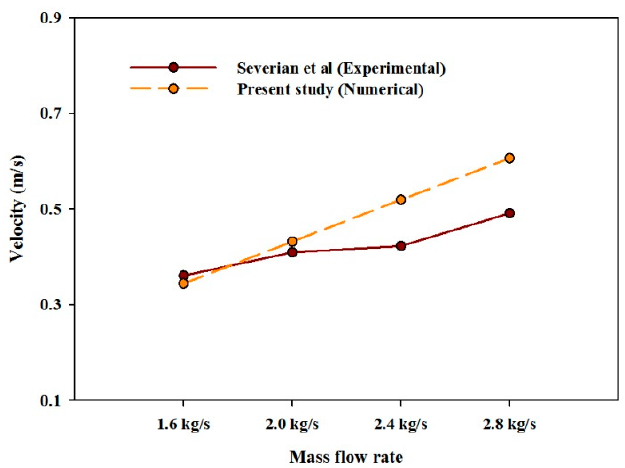
Figure 2. Comparison of the present study with the experimental results of Apel et al. [11].